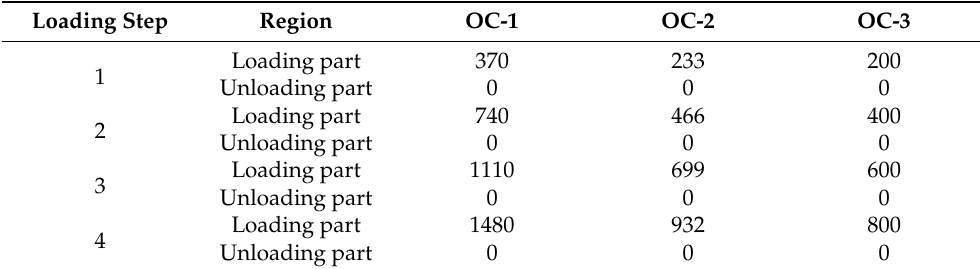
Table 5. Loading values for the half-span loading test (unit: